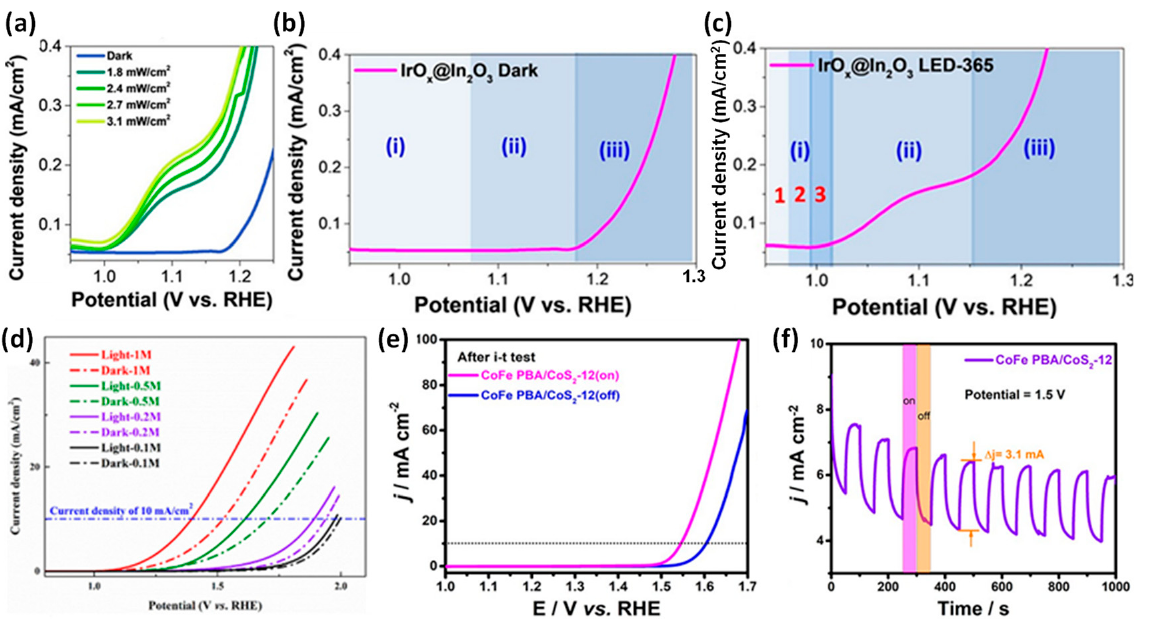
Figure 4. ( a ) The enlarged LSV curves of IrOx@In 2 O 3 in the dark and under LED—365 illumina- tion. OER mechanistic analysis of IrOx@In 2 O 3 ( b ) in the dark and ( c ) under LED—365 illumination. Adapted with permission from ref. [47]. Copyright 2021, Wiley-VCH. ( d ) LSV curves of BP QDs/MoS 2 in different KOH concentrations under light and dark conditions. Adapted with permission from ref. [78]. Copyright 2021, Elsevier. ( e ) LSV curves of CoFe PBA/CoS 2 -12 under dark and light irradiation and ( f ) transient photocurrent test of CoFe PBA/CoS 2 -12 at 1.5 V. Adapted with permission from ref. [82]. Copyright 2019, Royal Society of Chemistry.